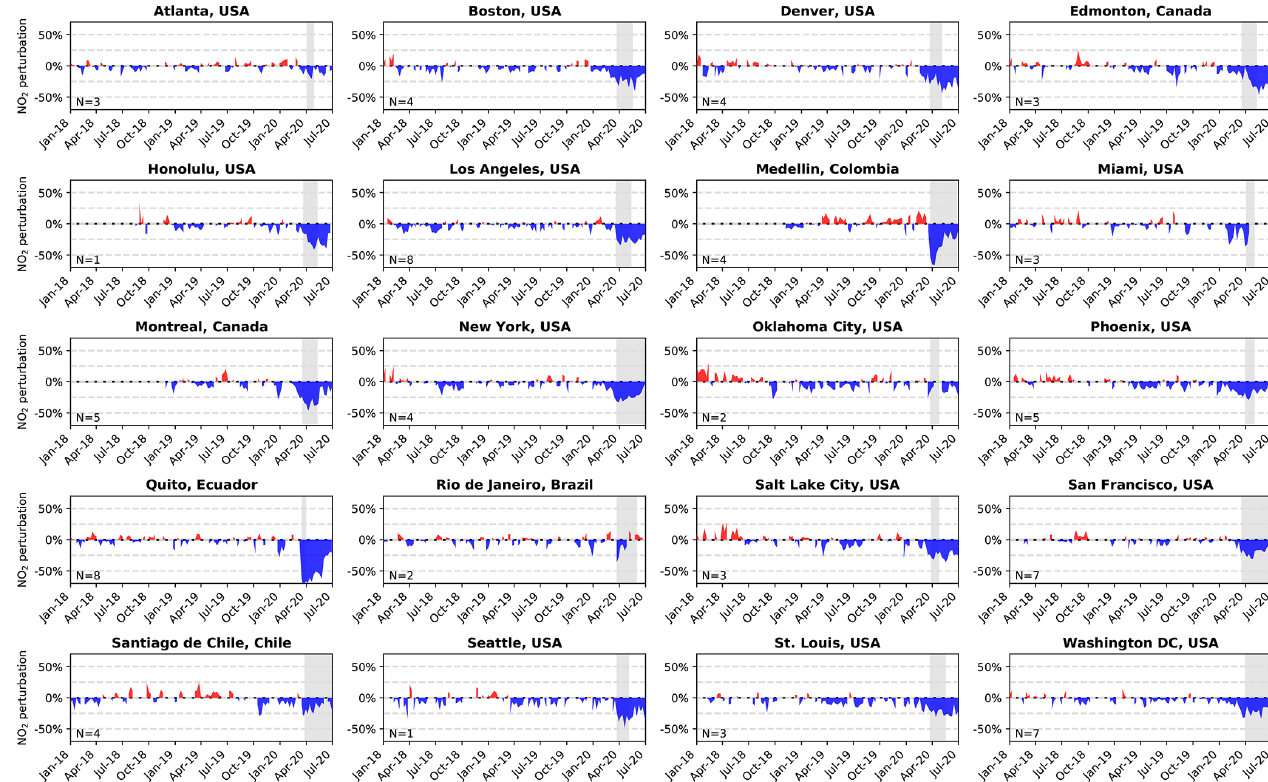
Figure A8. The same as Fig. A6 but for North and South